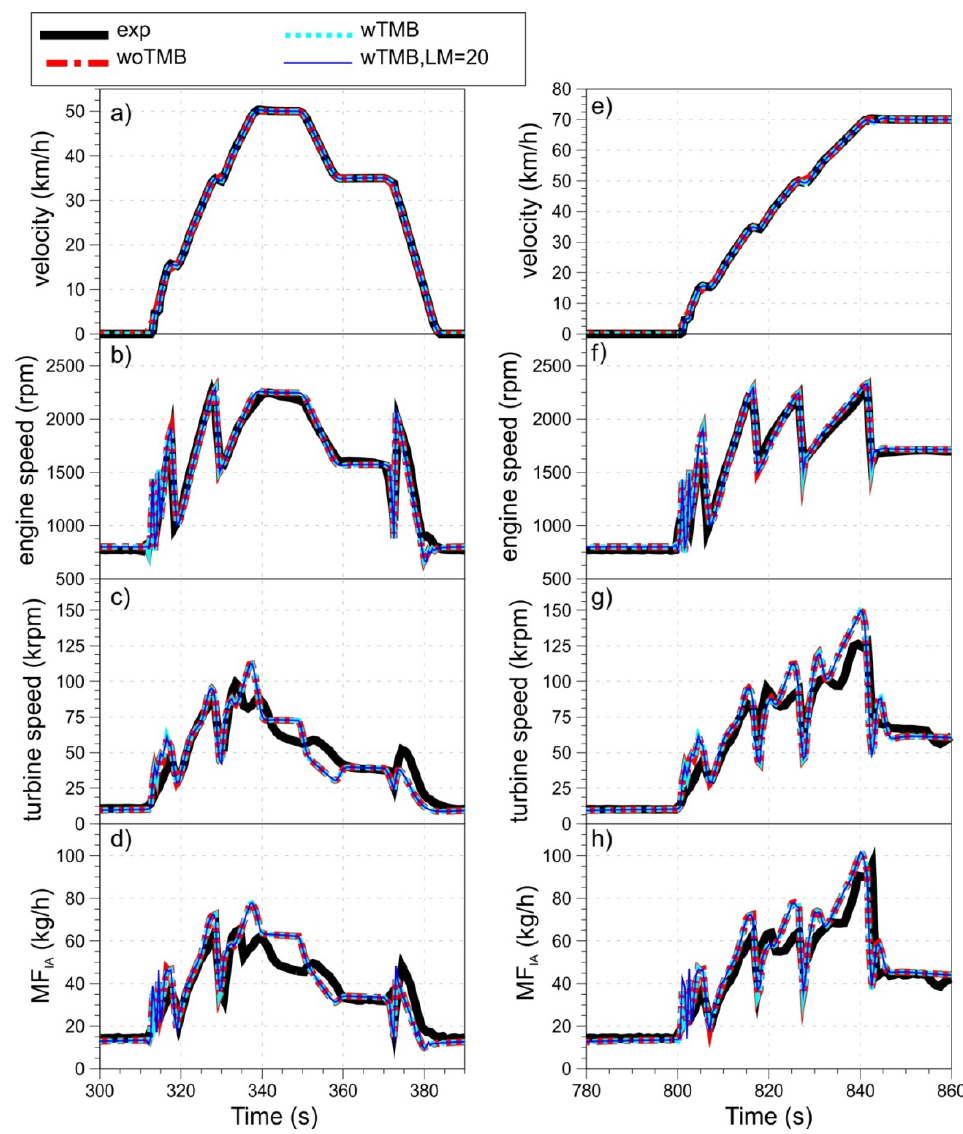
Figure 6. Results of the two NEDC segments showing a comparison of the experimental results (exp) to the results without the TMB (woTMB), with the TMB (wTMB) and with the TMB where all the lengths in the transfer elements were multiplied by an excessively high factor of 20 (wTMB,LM = 20) for vehicle velocity ( a – e ), engine speed ( b – f ),